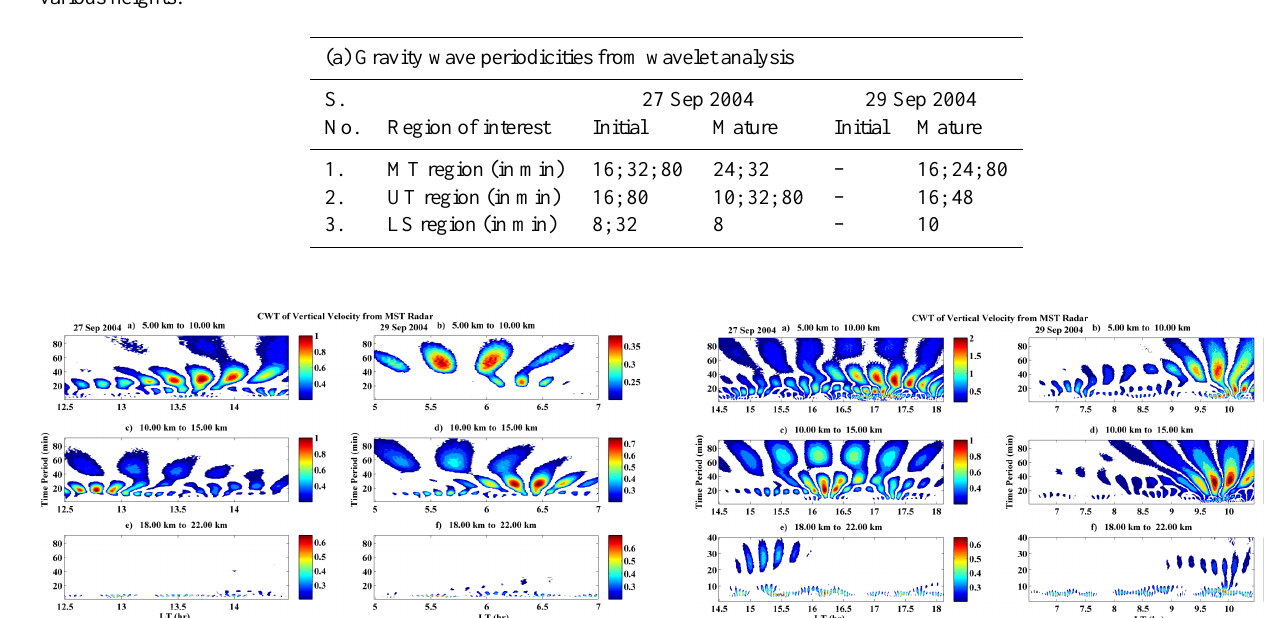
Table 1. (a) The vertical wavelengths of temperature, zonal and meridional wind perturbations calculated using a fast Fourier transform at various heights.